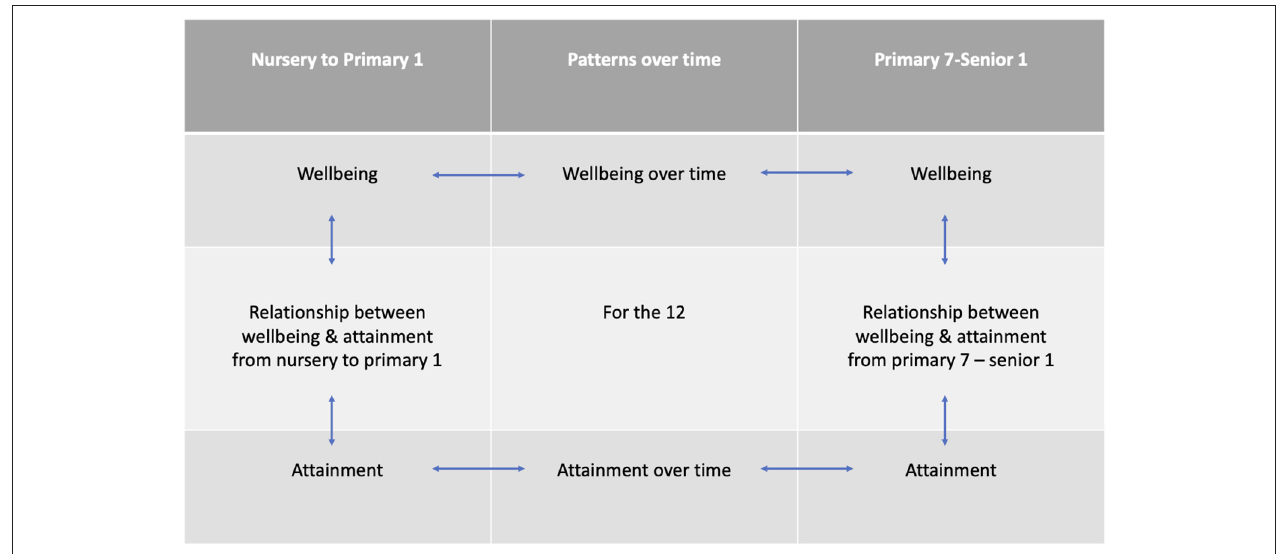
FIGURE 4 | Model of wellbeing and attainment patterns over